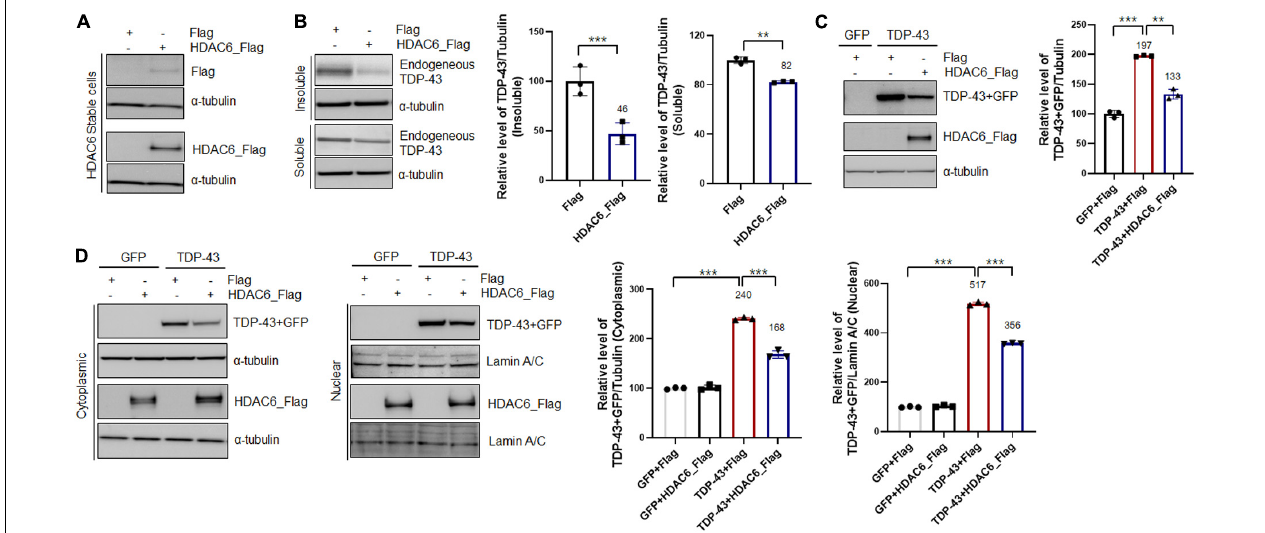
FIGURE 1 | Overexpression of HDAC6 suppresses the aggregation and mislocalization of TDP-43. (A,B) Stable Flag- or HDAC6-Flag-expressing cell lines were analyzed by immunoblotting. (A) Cell lysates were prepared, and samples were immunoblotted with an anti-Flag or HDAC6 antibody. (B) Protein levels of soluble and insoluble TDP-43 in HDAC6-Flag-expressing cells. Flag- or HDAC6-Flag-expressing cells were fractionated to generate a supernatant (the soluble fraction) and a pellet (the insoluble fraction) using lysis buffer containing 1% Triton X-100. Both soluble and insoluble TDP-43 protein levels were significantly decreased by HDAC6-Flag expression. Data are presented as the mean ± SD of three independent experiments. ** p < 0.005 and *** p < 0.001 (Student’s t -test). (C,D) Stable Flag- or HDAC6-Flag-expressing cells were transiently transfected with a plasmid containing either Gfp or TDP-43-Gfp for 2 days. (C) Immunoblot analysis of an anti-TDP-43 or HDAC6 antibody. HDAC6 overexpression markedly decreased the level of TDP-43. Data are presented as the mean ± SD of three independent experiments. ** p < 0.005 and *** p < 0.001 (one-way ANOVA with Tukey’s multiple comparison test). (D) Protein levels of nuclear and cytoplasmic TDP-43 or HDAC6. HDAC6 overexpression significantly reduced the protein levels of cytoplasmic and nuclear TDP-43 in TDP-43-GFP-expressing cells. Bar graph of the expression levels of cytoplasmic and nuclear TDP-43 normalized to that of tubulin or Lamin A/C. Data are presented as the mean ± SD of three independent experiments. *** p < 0.001 (one-way ANOVA with Tukey’s multiple comparison